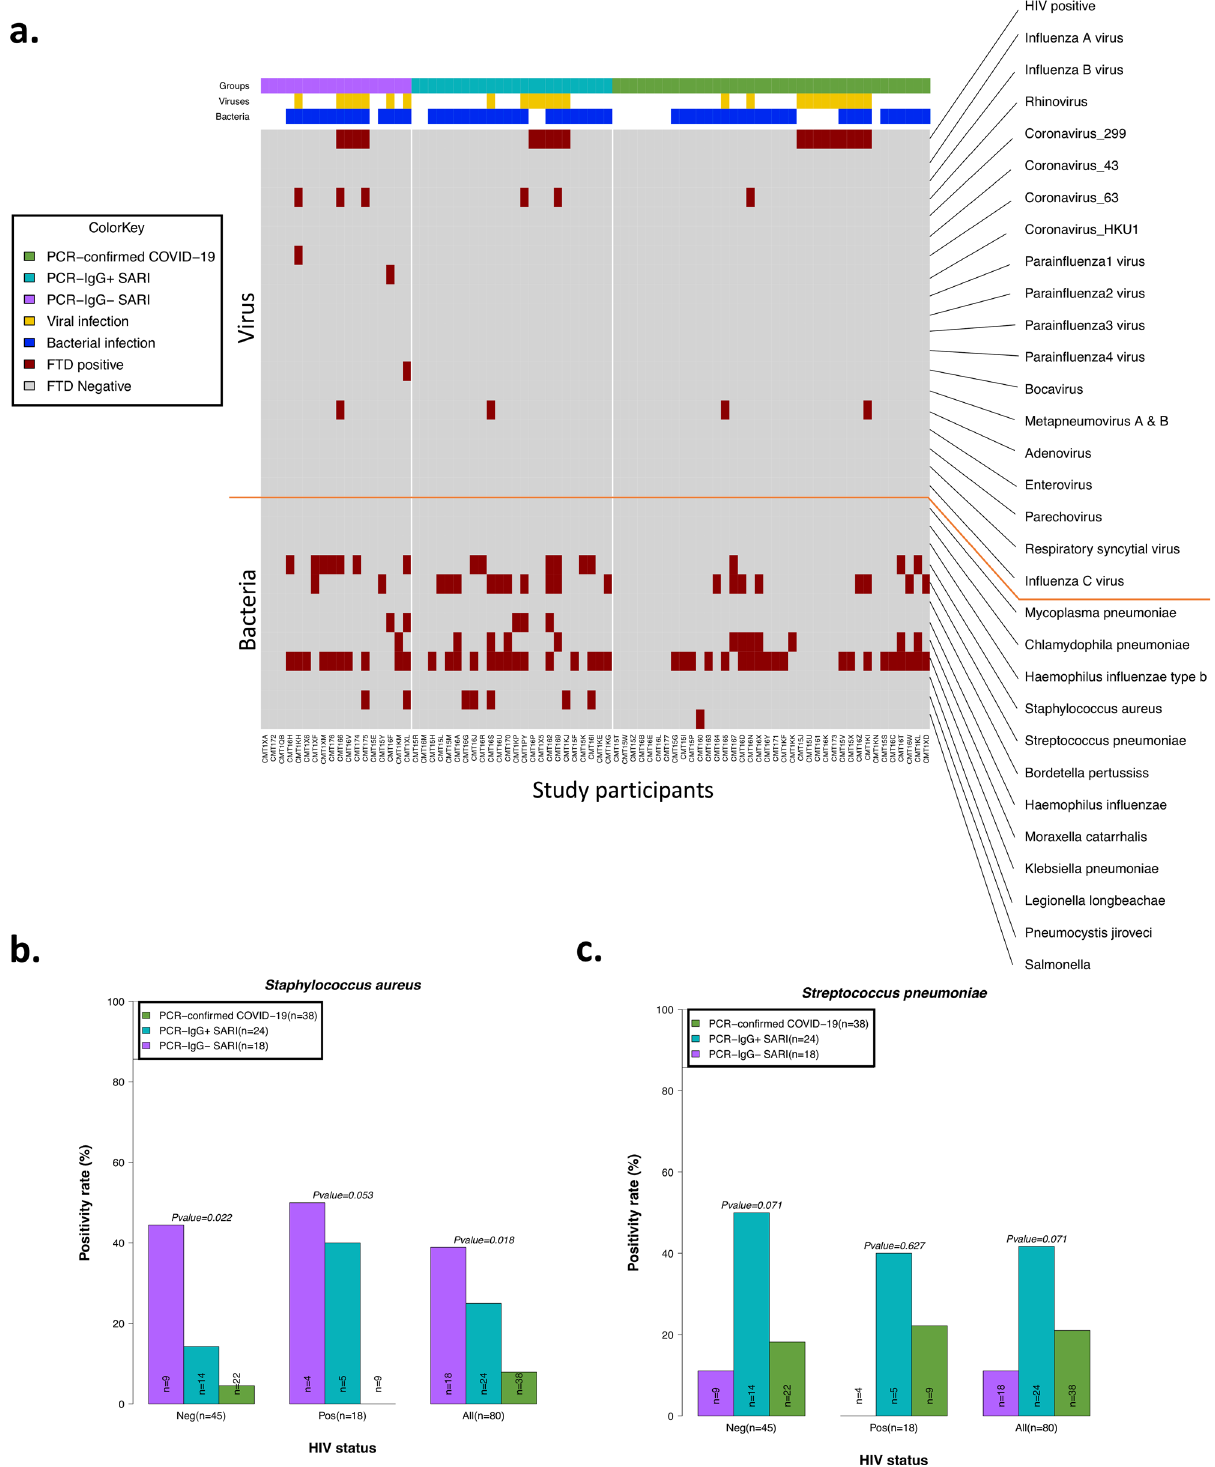
Fig. 5 Co-colonisation/infection status of suspected and con fi rmed COVID-19 patients. a Pro fi le of co-colonisation/infection pathogens in nasopharyngeal/throat swabs. Prevalence of b Staphylococcus aureus and c Streptococcus pneumoniae co-colonisation in suspected and con fi rmed COVID-19. The horizontal bars represent the median and interquartile range (IQR). Data were analysed using Kruskal – Wallis test (PCR-con fi rmed COVID-19, n = 39; PCR − /IgG + SARI, n = 23; PCR − /IgG − SARI, n = 22). COVID-19 coronavirus disease of 2019. Source data are provided as a Source Data fi le. SARI participants. The PCR-con fi rmed COVID-19 participants had lower prevalence rates of Staphylococcus aureus (3/38 [8%] vs. 6/24 [25%], p = 0.018) and tended toward lower Strep- ences between PCR-con fi rmed COVID-19 and PCR − /IgG + tococcus pneumoniae (8/38 [21%] vs. 10/24 [42%], p = 0.071) NATURE COMMUNICATIONS| (2021) 12:3554